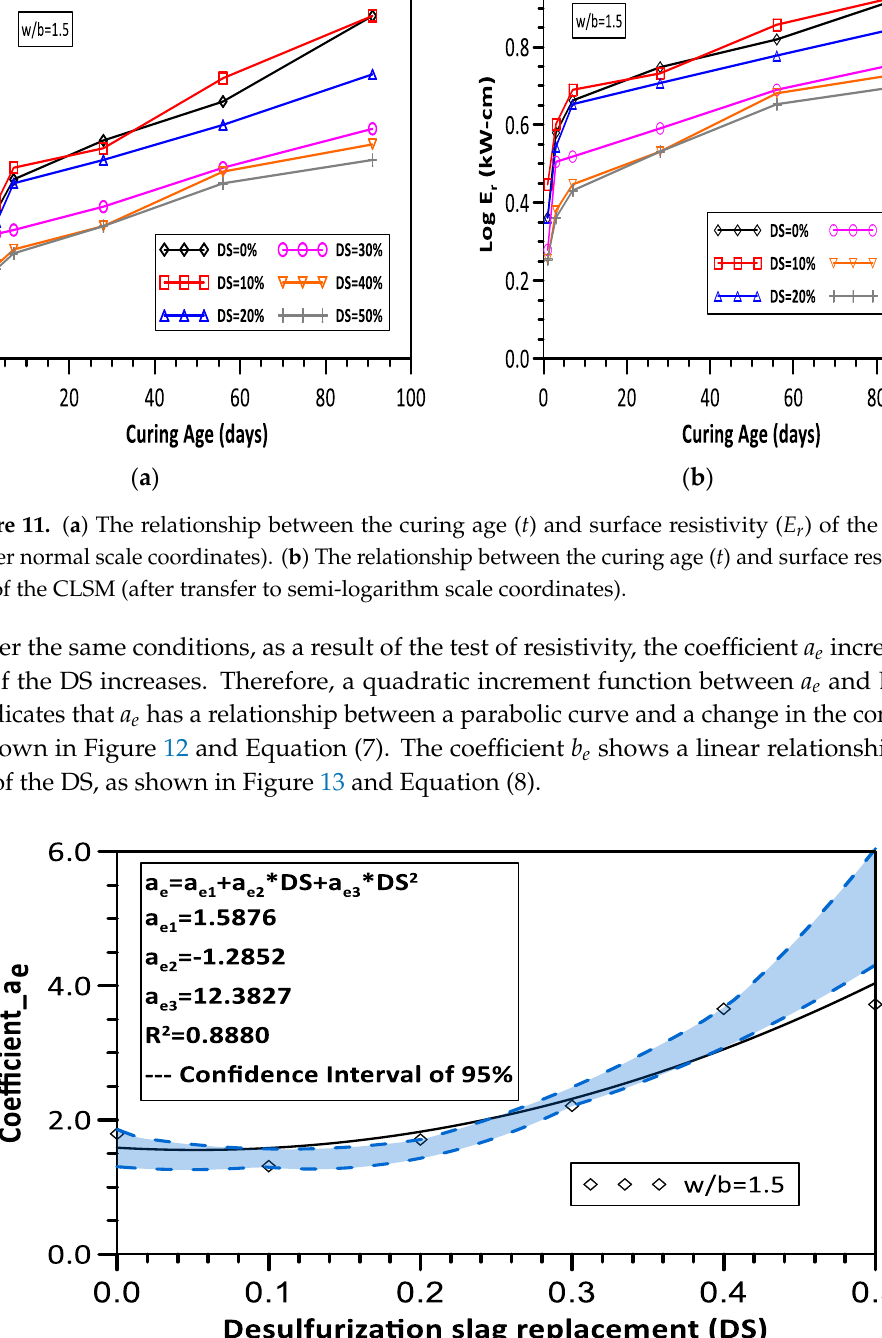
Figure 13. Characteristics of the coefficient 𝑏 𝑒 of the surface resistivity prediction model versus the DS content. 4.3. Relationship Between Compressive Strength and Electrical Resistivity Previous researchers have applied the resistivity of concrete to predict the compressive strength, and such studies often involve the development of a relationship between resistivity and compressive strength. Previous studies have concluded that there is a good correlation between resistivity and compressive strength for concrete with a specific water-binder ratio. However, the compressive strength of concrete increases linearly or nonlinearly with resistivity (Lubeck et al., 2012 [19], Liu and Presuel-Moreno, 2014 [20], Xiaosheng et al., 2012 [21], Kahraman and Alber, 2014 [26], and Ramezanianpour et al., 2014 [27]). Thus, the relationship between the surface resistivity and compressive strength may be related to the water-binder ratio of the concrete. Figure 14 shows the test results between the surface resistivity and the compressive strength of the CLSM when the water- binder ratio is 1.5 and at different DS contents. For the same DS content, the compressive strength 𝑓 𝑐,′ increases with the resistivity 𝐸 𝑟 , and the increasing trend is a smoothed nonlinear function. Thus, in the process of establishing the predictive model, the study will ignore the influence of the water- binder ratio’s change and use the hyperbolic function to simulate the relationship between the compressive strength and resistivity of the CLSM, as shown in the Equation (9), Where 𝑎 𝑒𝑟 and 𝑏 𝑒𝑟